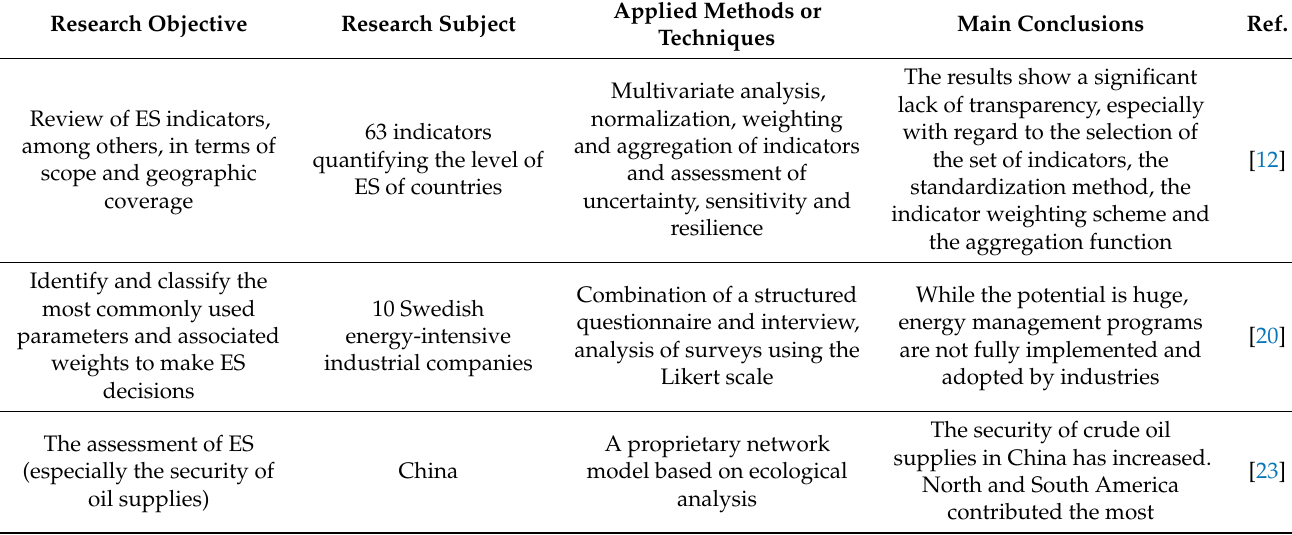
Table 2. Other research in the field of energy security